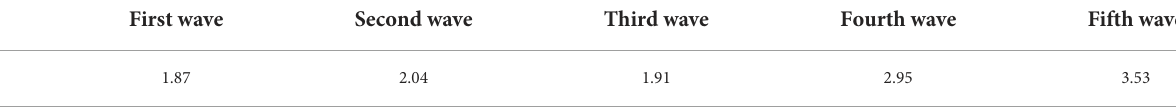
FIGURE4 Distribution of MeanR among 30 countries in Africa.